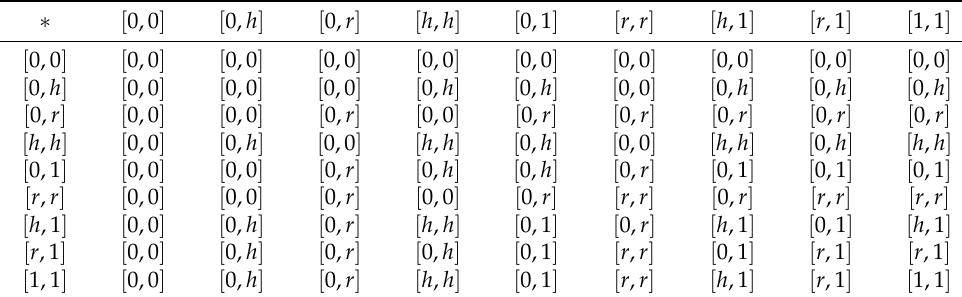
Table 1. The operator ∗ of algebra in Example